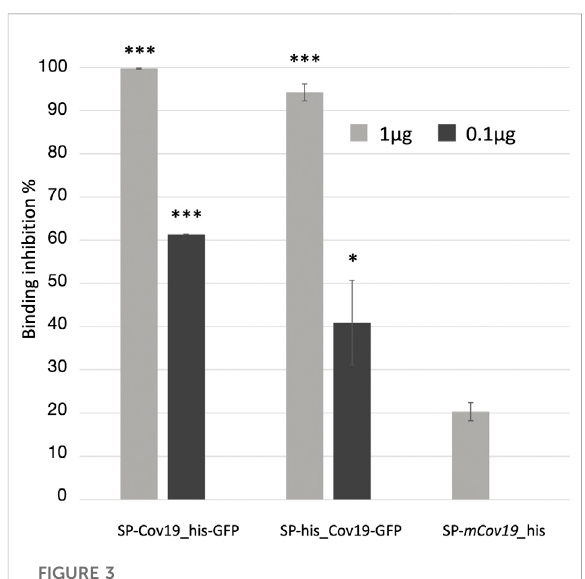
Competitive ELISA inhibition of ACE2 and RBD binding using anti RBD nanobodies. Competition binding assays were used to investigate whether the SP-Cov19_his-GFP and SP- his_CoV19-GFP blocked the binding of RBD to ACE2 compared to the mutant version SP- mCov19 _his. SP- CoV19_his-GFP, SP-his_CoV19-GFP and SP-mCov19_his at 1 μ g/mL and 0.1 μ g/mL were incubated with RBD proteins, both SP-CoV19_his-GFP, SP-his_CoV19-GFP inhibited RBD bound to ACE-2 but SP-mCoV19_his at 1 μ g/mL (Bars represent standard deviation, the asterisks indicate signi fi cant differences between conditions, * = p < .05, ** = p < .005, *** = p <